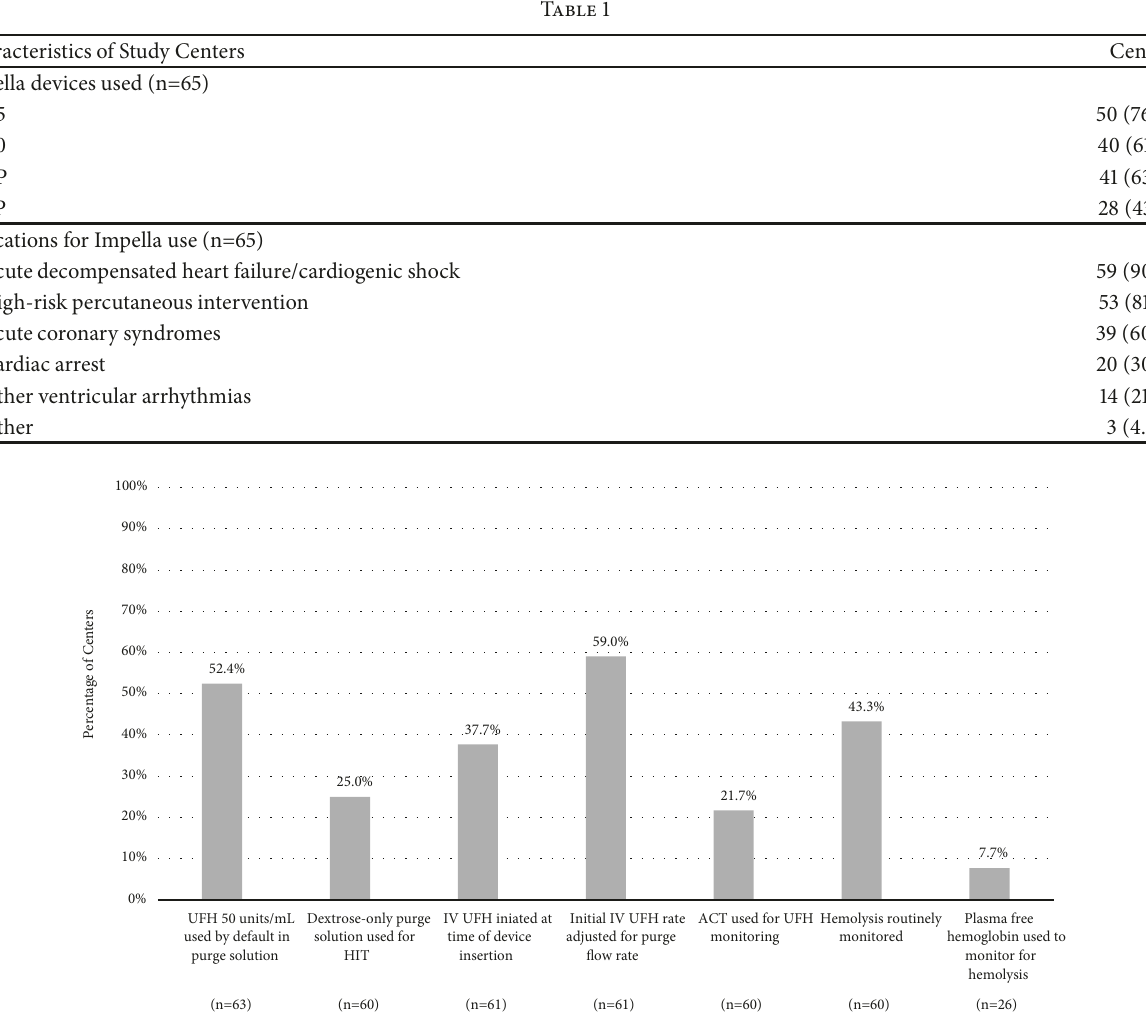
Figure 2: Summary of Impella Anticoagulation Practices . No consensus emerged with regard to any of the practices queried in the survey. A slight majority of centers used the default concentration of UFH recommended by the manufacturer and adjusted the initial IV UFH rate for purge flow. Many of the above practices diverge from the manufacturers’ recommendations. Abbreviations: ACT: activated clotting time, IV: intravenous, and UFH: unfractionated